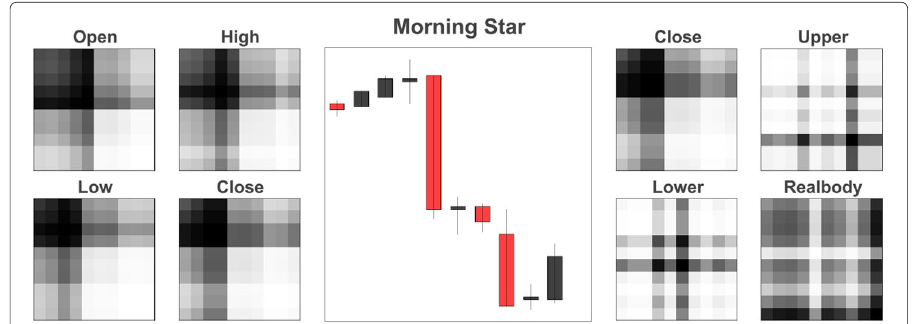
price, upper shadow, lower shadow, and real-body